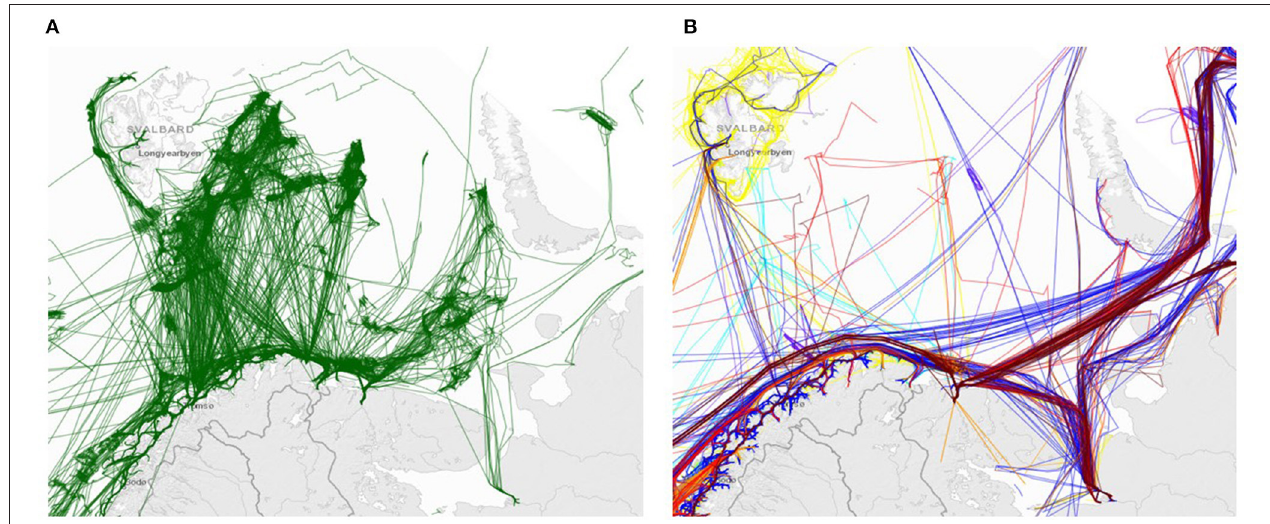
Frontiers in Marine Science |